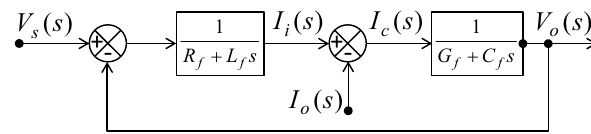
Table 1 Parameters used for the PLL design